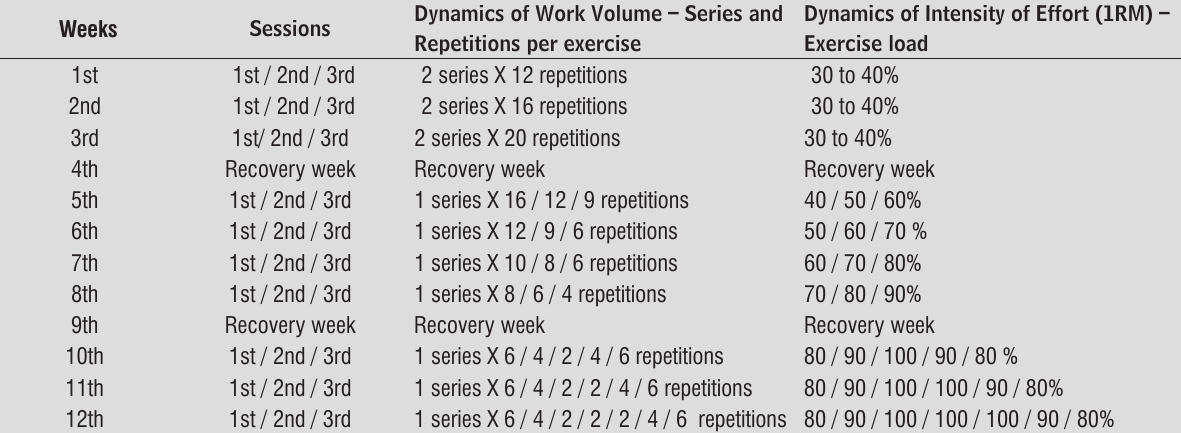
Table 1 - Training development according to the dynamics of the exercises and sessions Weeks